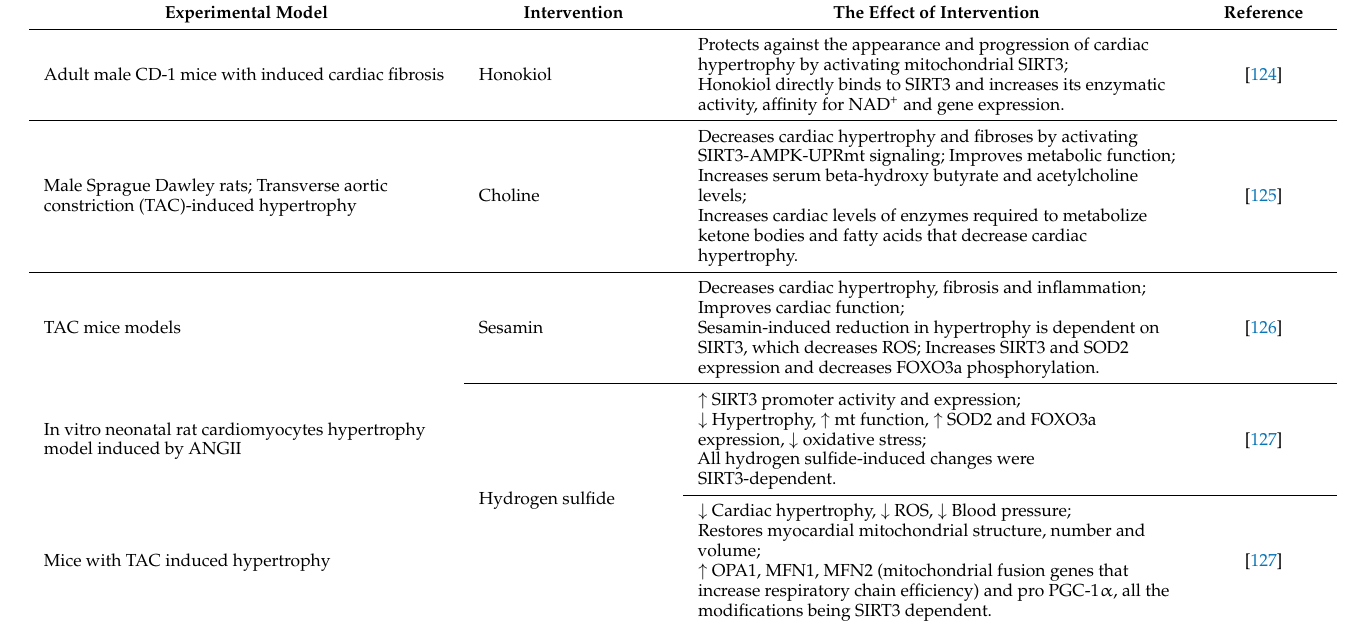
Table 2. Interventions that modulate SIRT3 signaling in cardiac